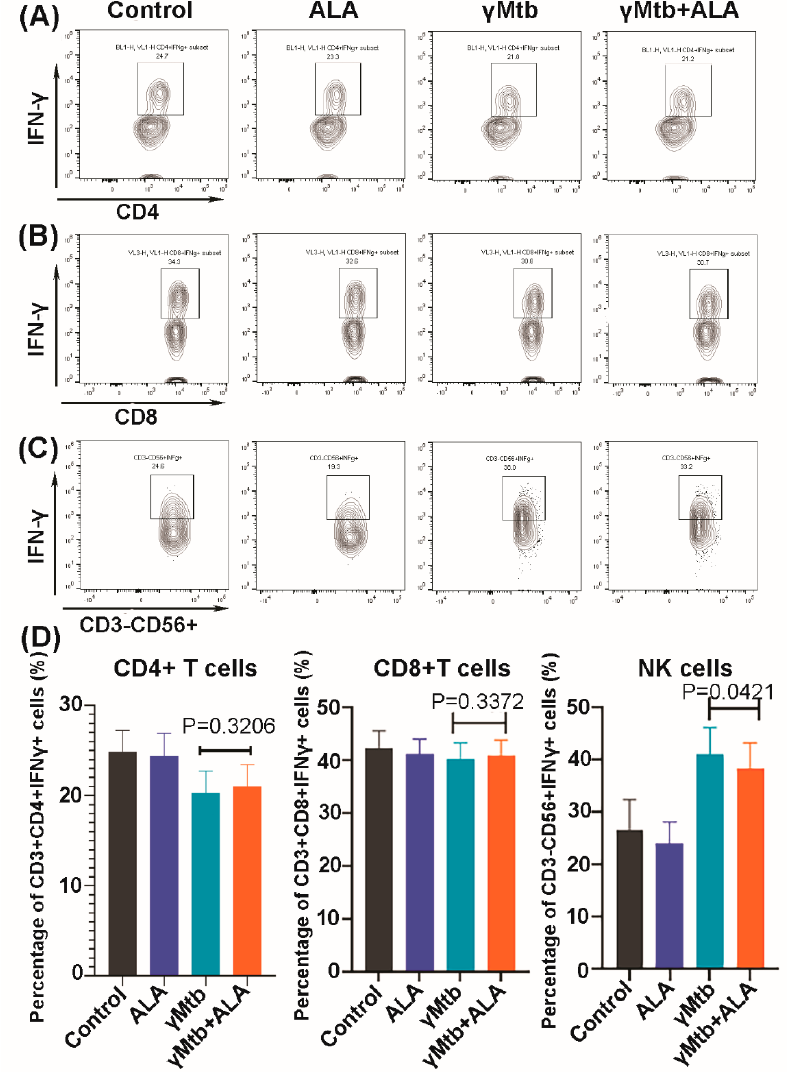
Figure 4. IFN- γ levels of various immune cells in γ Mtb -cultured PBMCs of LTBI+ donors. PBMCs of healthy LTBI+ donors were cultured with or without γ Mtb (10 µg/mL) and in the presence or absence of ALA, as mentioned in the Methods section. After 48 h, intracellular staining was performed to determine IFN- γ levels of various immune cell populations: ( A – C ) IFN- γ staining of a representative donor PBMC; the top, middle and bottom panels represent CD4+ T cells ( A ), CD8+ T cells ( B ), and NK cells ( C ), respectively. The percentages of IFN- γ -positive cells are shown; ( D ) collective summary of IFN- γ -positive CD4+, CD8+, and CD56+ cells of five donors. Paired t -tests were used to compare the differences between untreated and treated PBMCs from the same samples. The significant p values are shown in the fi gure.